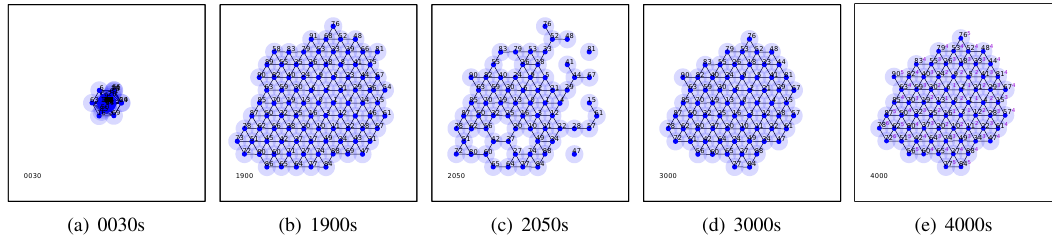
Fig. 9: EMR algorithm presented in this paper. Deployment snapshots with 30% of node disappearing at 2000s and the self-healing mechanisms.